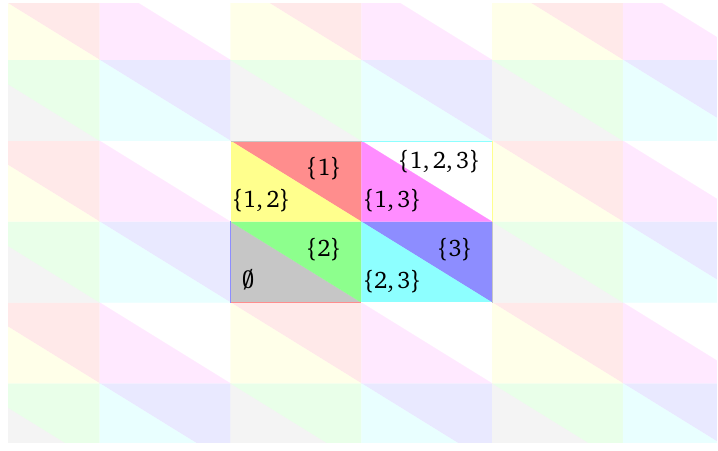
Figure 10: Representation of the torus homeomorphic to the Riemann surface R Opposite sides of the fundamental domain represented by the region in the middle are identified. The connectivity of the sheets G the labels P ⊂ { 1,2,3 } of the